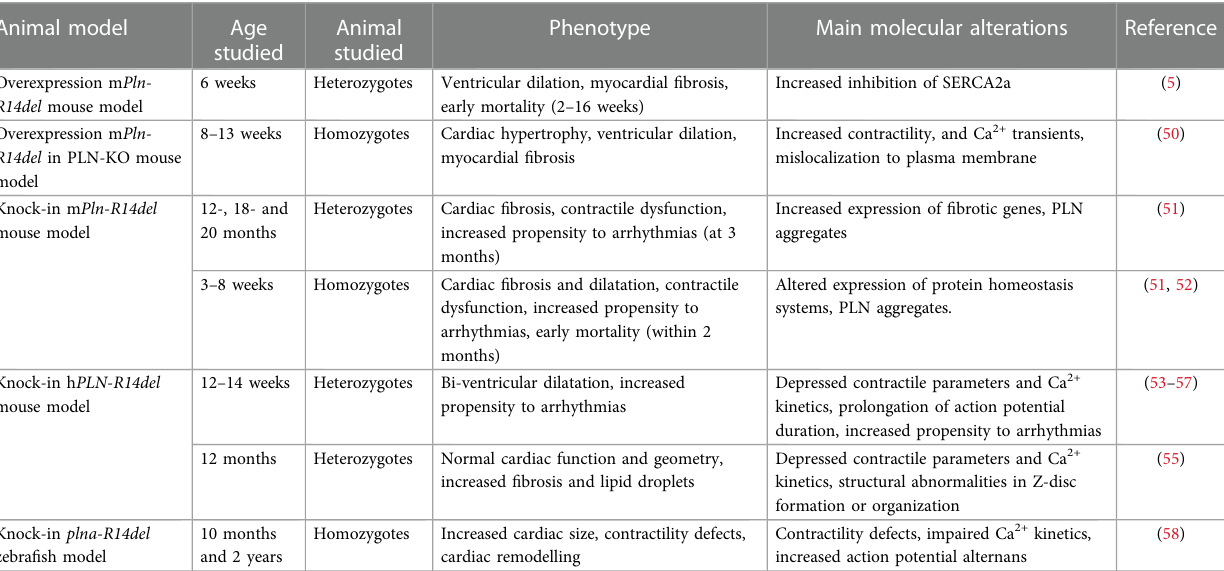
TABLE 1 PLN-R14del animal models and key phenotypic